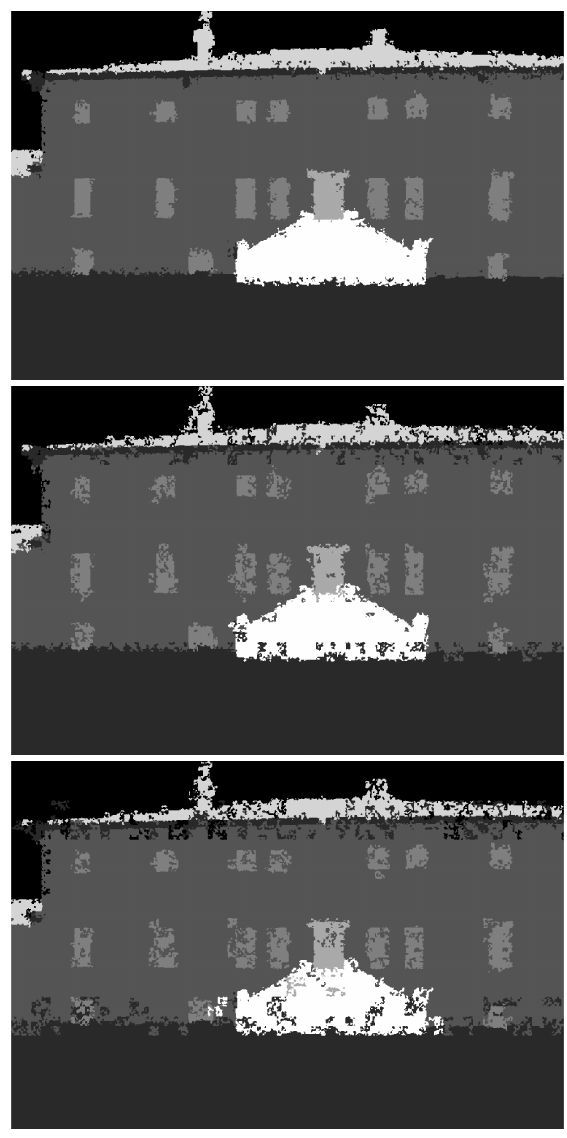
Figure 4. Example of synthetic labeled images derived from Fig- ure 3 increasing the level of random noise.